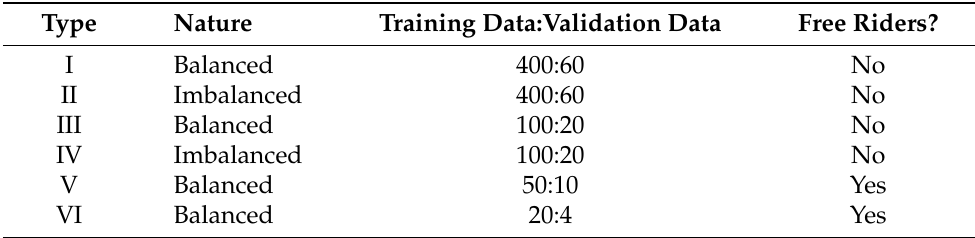
Table 3. Definition of datasets associated with each client under different environments.